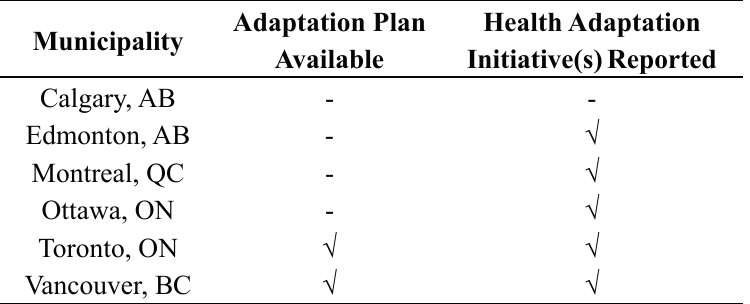
Table 4. Adaptation plans and initiatives in Canada’s largest